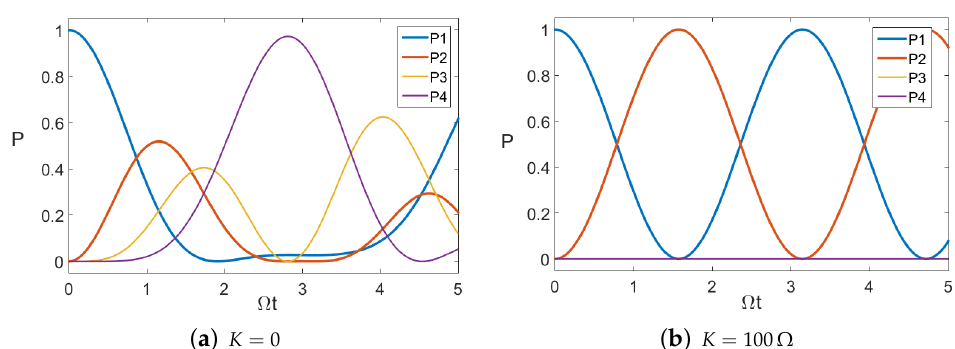
Figure 4. Populations P k with Ω 1 = Ω 2 = Ω 3 ≡ Ω without control potential ( a ) and with the control potential turned on with K = 100 Ω ( b